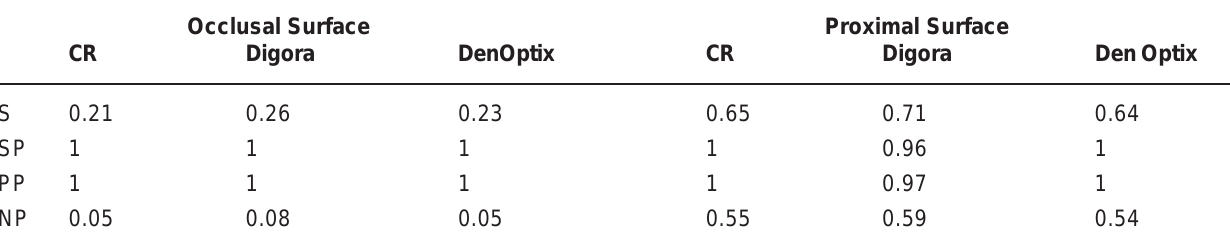
TABLE 2- Values of Sensitivity (S), Specificity (SP), positive predictive (PP), Negative predictive (NP) for the Conventional